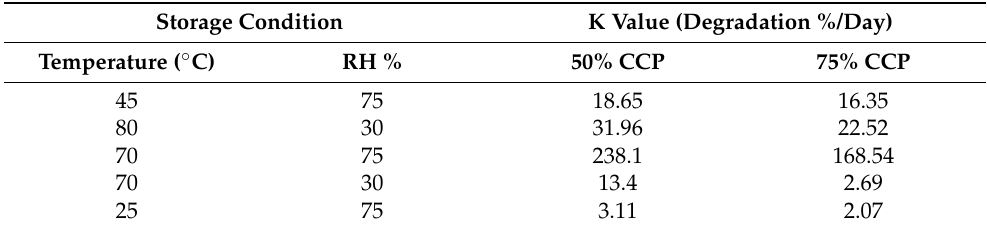
Table 1. C3G experimental k values extrapolated from the degradation kinetic curves registered for MCE-CCP 50/50 and MCE-CCP 25/75 under five different storage conditions. Storage Condition K Value (Degradation %/Day) Temperature ( ◦ C) RH % 50%